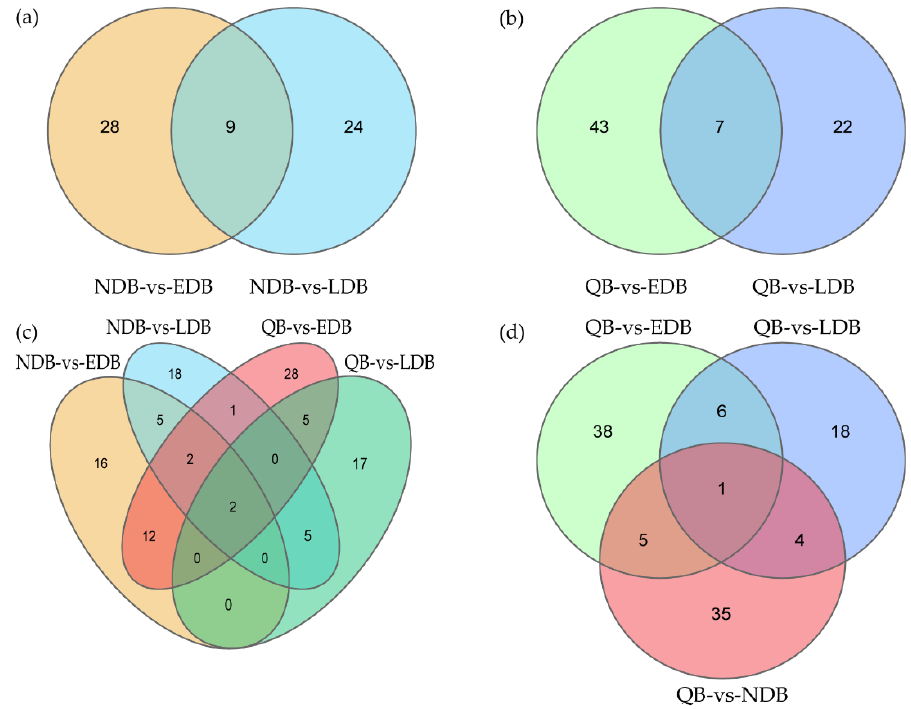
Figure 2. Venn diagram of differentially expressed lncRNAs in honey bees of different comparison groups. Based on the comparison results of different groups of honey bees, some specific and common DElncRNAs were identified using the Venn diagram. ( a ) Venn diagram of DElncRNAs between NDB-vs-EDB and NDB-vs-LDB. ( b ) Venn diagram of DElncRNAs between QB-vs-EDB and QB-vs-LDB. ( c ) Venn diagram of DElncRNAs between NDB-vs-EDB, NDB-vs-LDB, QB-vs-EDB and QB-vs-LDB. ( d ) Venn diagram of DElncRNAs between QB-vs-EDB, QB-vs-LDB and QB-vs-NDB. Note: EDB referred to the waggling dancers after foraging on a feeder with 1.5 M sucrose solution in the first phase. NDB referred to the non-dancing bees after foraging on another feeder with 0.5 M sucrose solution replacing the feeder with 1.5 M sucrose solution in the second phase. LDB referred to the waggling dancers after foraging on the feeder with 1.5 M sucrose solution replacing the feeder with 0.5 M sucrose solution in the third phase. QB referred to quiescent bees on the comb after removing the feeder for 1 h in the fourth phase.